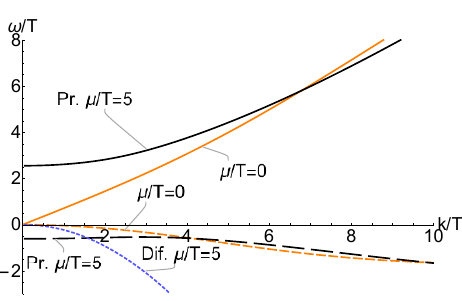
Figure 1 . The lowest ε = 0 modes for the RN background at µ/T = 0 and µ/T = 5. Imaginary parts are dashed. Note the sound mode whose imaginary part vanishes as k/T approaches zero and the gapped prop- agating plasmon mode (Pr.) with initially larger imaginary part than the purely diffu- sive mode (Dif.).